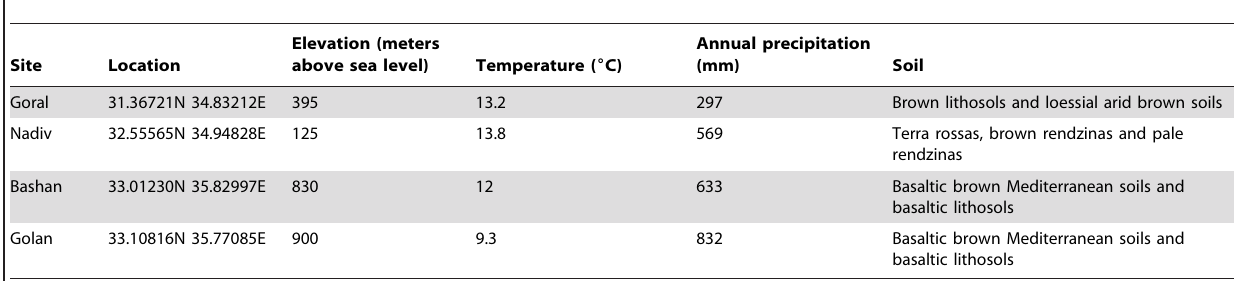
Table 1. Environmental factors at each of the four sites (Goral, Nadiv, Bashan and Golan).